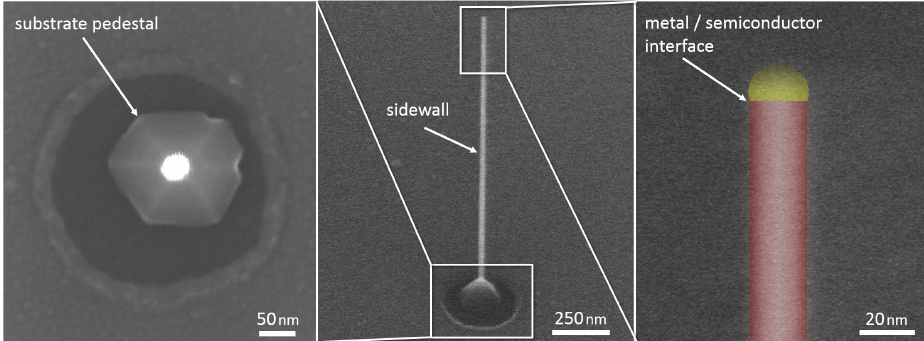
Figure 3. SEM images of a template nanowire showing incorporation sites. Middle and right panels are views at 45 ◦ whilst left panel is a plan view. Right panel is in false